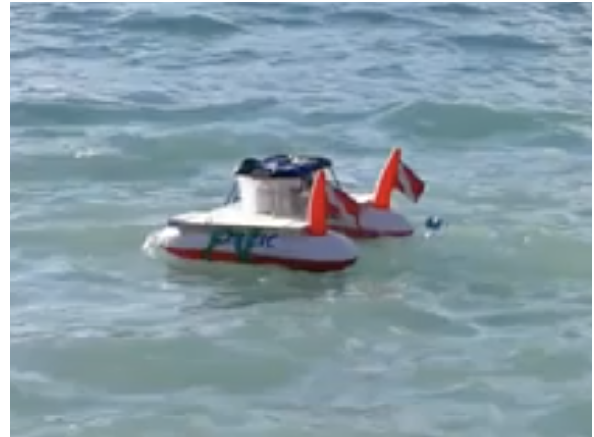
Figure 4. Our land vehicle: Mabouya.